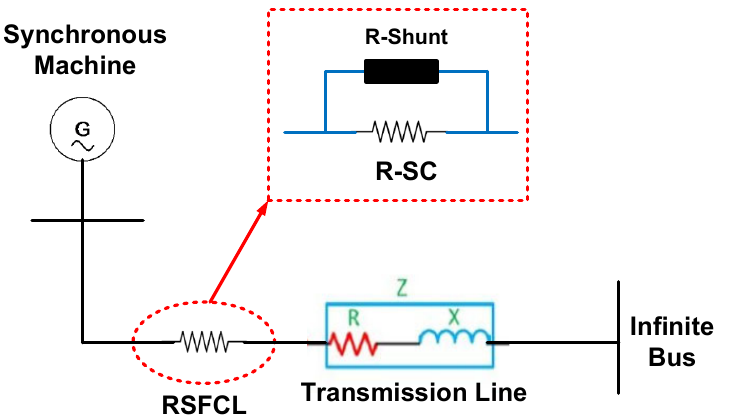
Figure 2. Simple model of a RSFCL in a SMIB system.